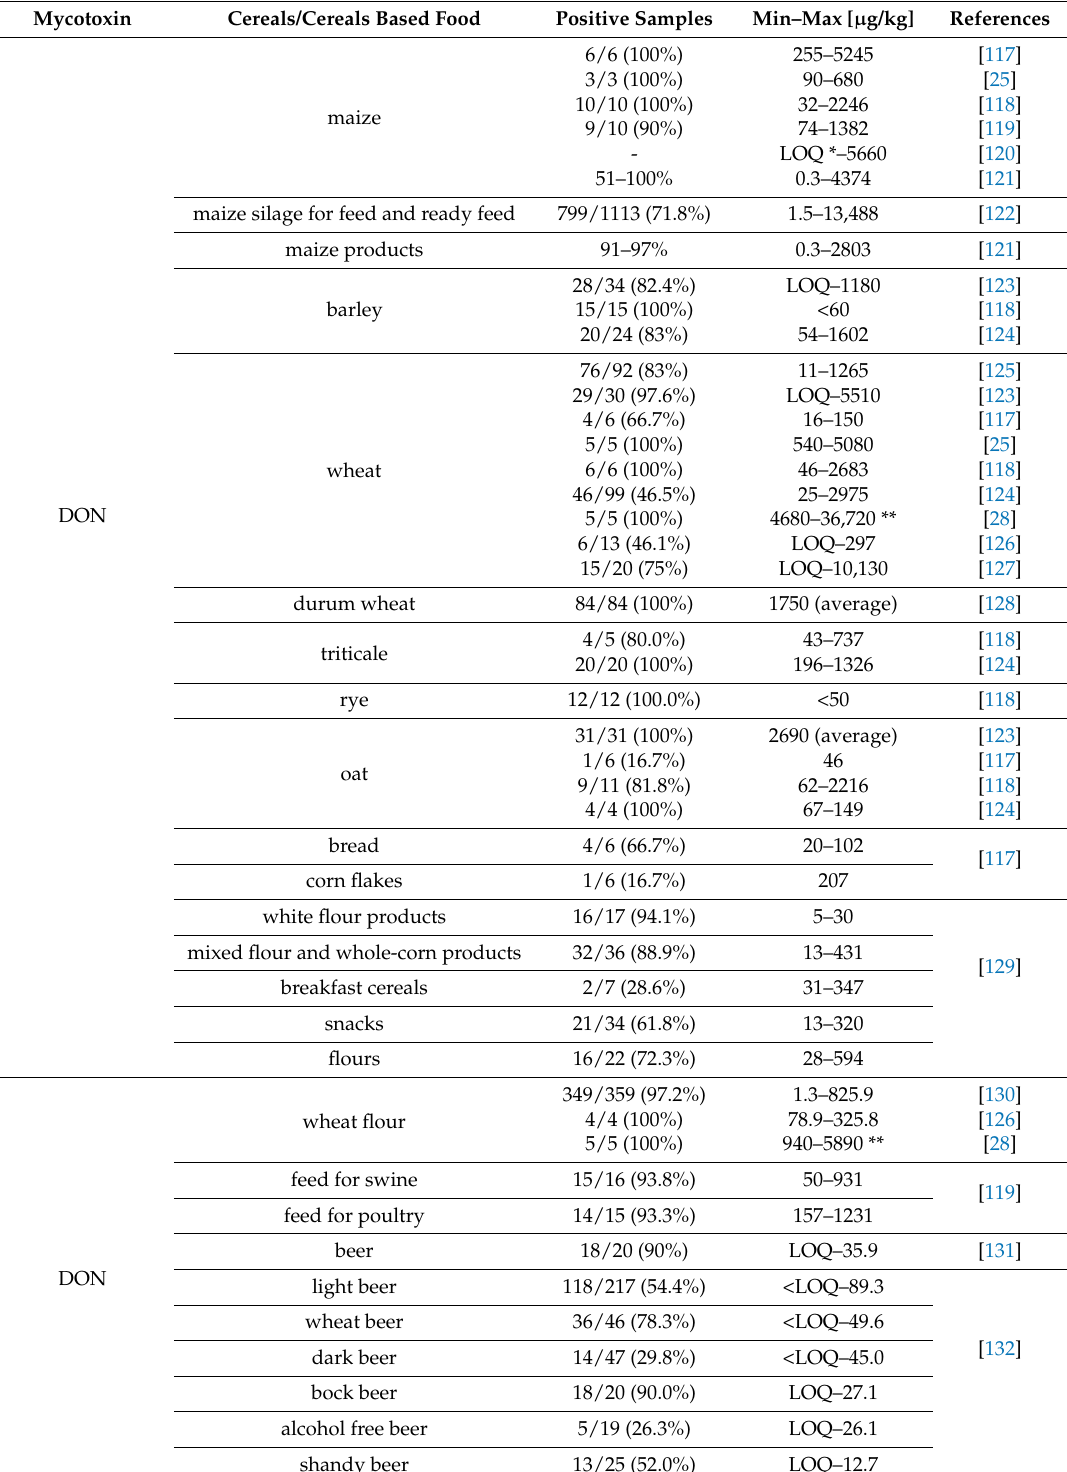
Table 1. Natural occurrence of modified mycotoxins in cereals and cereal-based foods and